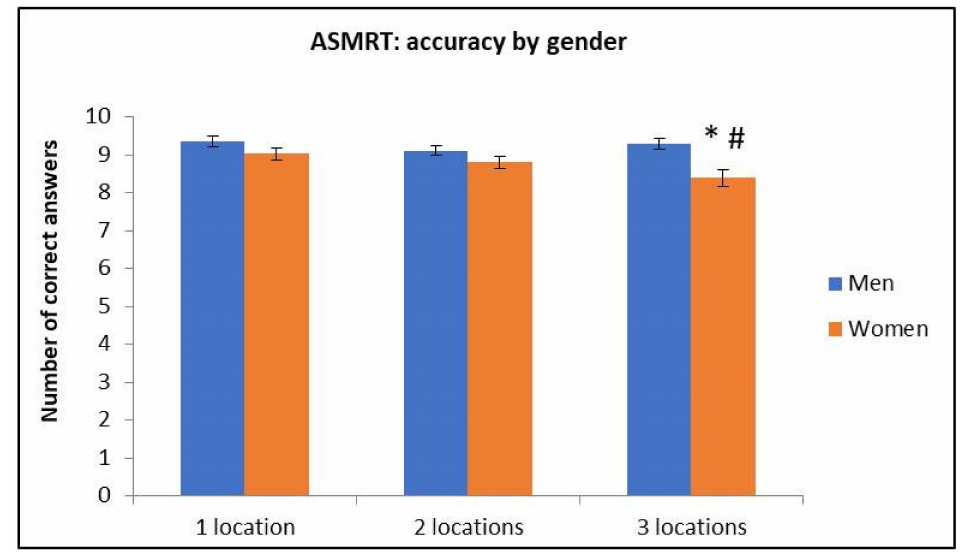
Figure 10. Number of correct answers in the ASMRT by Sex and Difficulty. * Differences between women and men; # Differences with 1-2 locations in women. (Mean ±